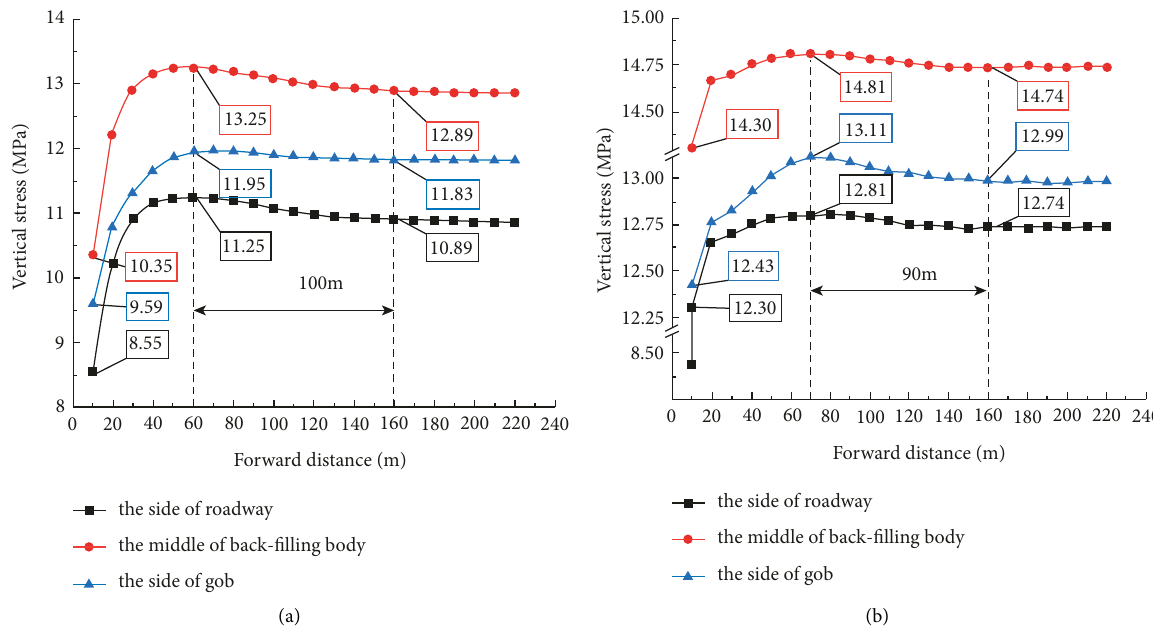
Figure 6: The stress distribution of the back-filling body under the influence of mining. (a) First mining. (b) Secondary